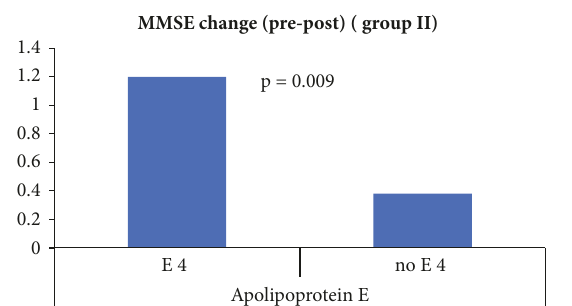
Figure 6: Group II mean PDCRS change in ApoE 𝜀 4 carrier/non-